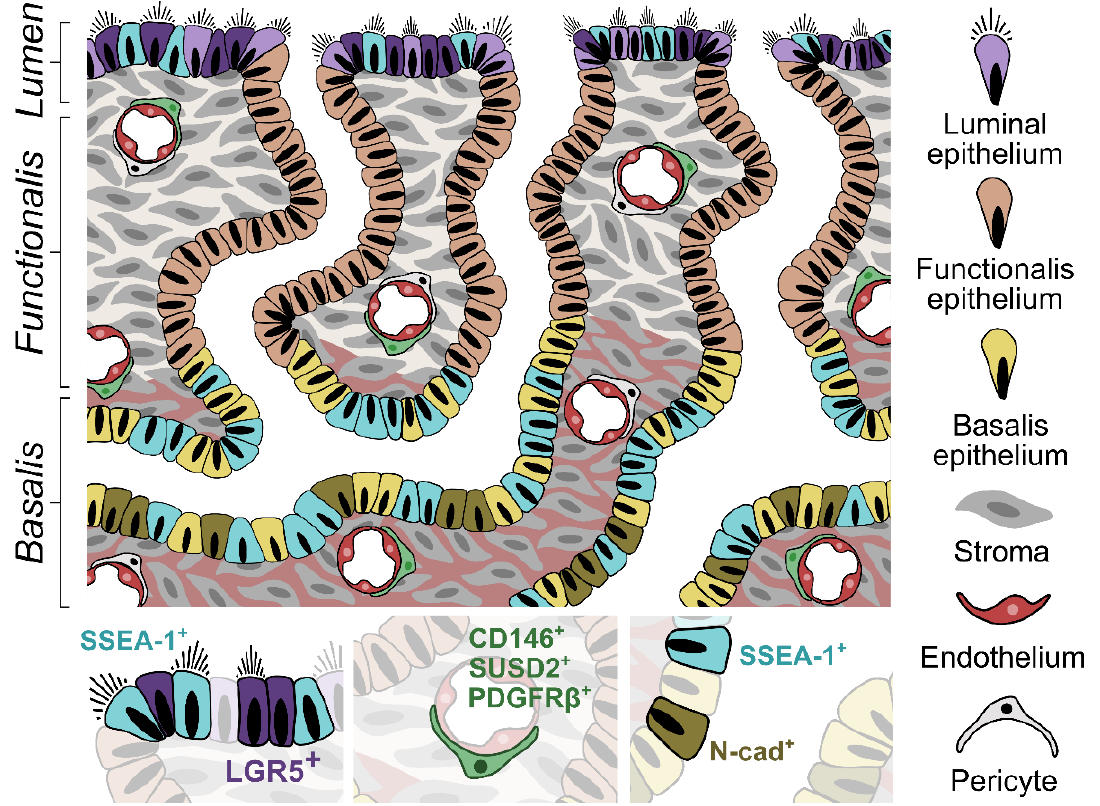
Figure 2. Proposed stem cell niches of the human endometrium. Stromal stem cells reside throughout the superficial and deep endometrial tissue as CD146 + , sushi domain containing-2 (SUSD2 + ), and platelet-derived growth factor receptor β positive (PDGFR β + ) perivascular cells. Putative epithelial stem cell populations have been described in the basalis layer, a region characterised by expression of progenitor markers, including leucine-rich repeat-containing G protein-coupled receptor 5 (LGR5), SRY-box 9 (SOX9), axis inhibition protein 2 (AXIN2), and nuclear β -catenin. Specific cells within the deeper basalis glands express N-cadherin, whilst stage-specific embryonic antigen-1 (SSEA-1) is characteristic of more superficial basalis regions.